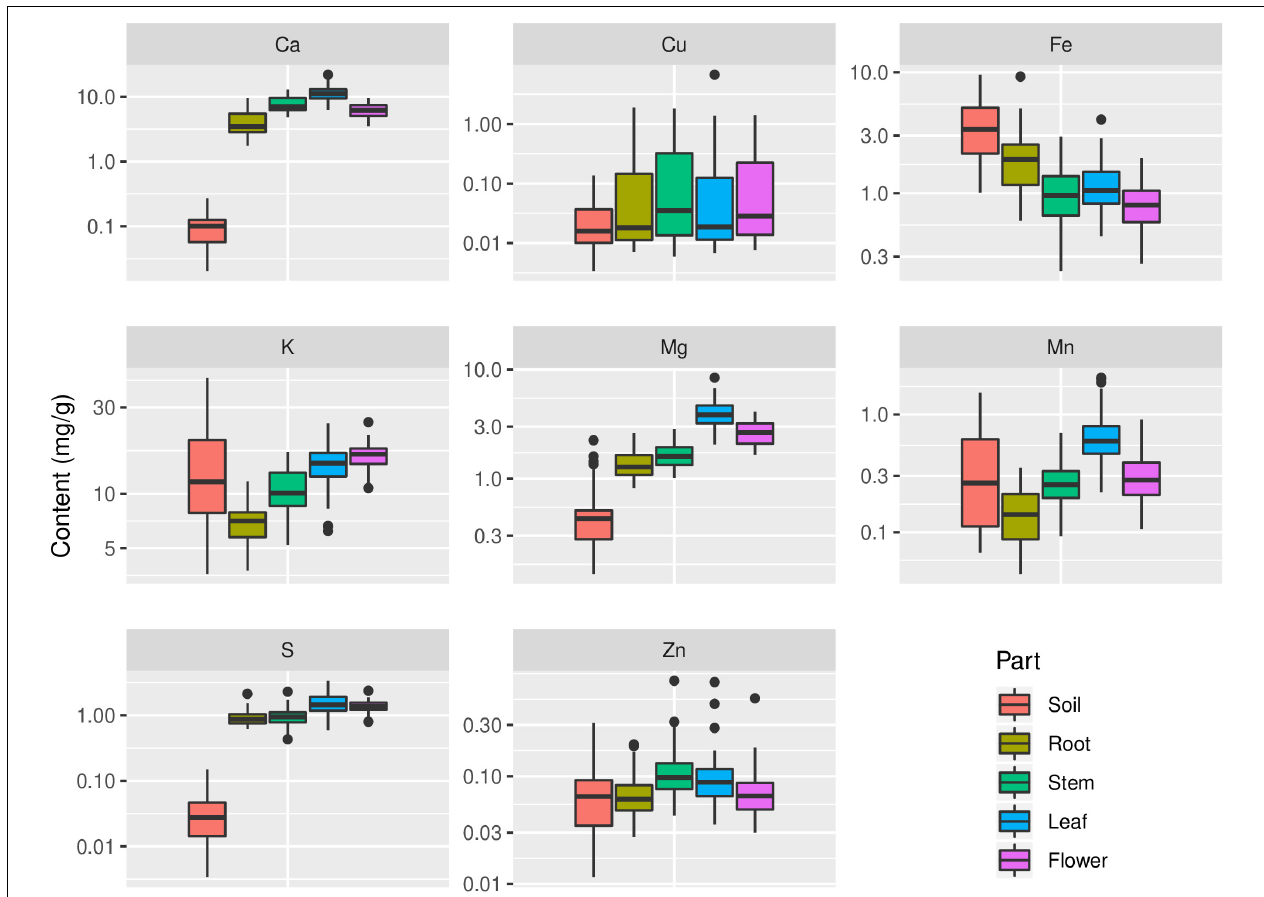
FIGURE 5 | Distribution of contents of Ca, Cu, Fe, K, Mg, Mn, S, and Zn in soils and plants. The sample size is 43 for soil and 45 for each plant